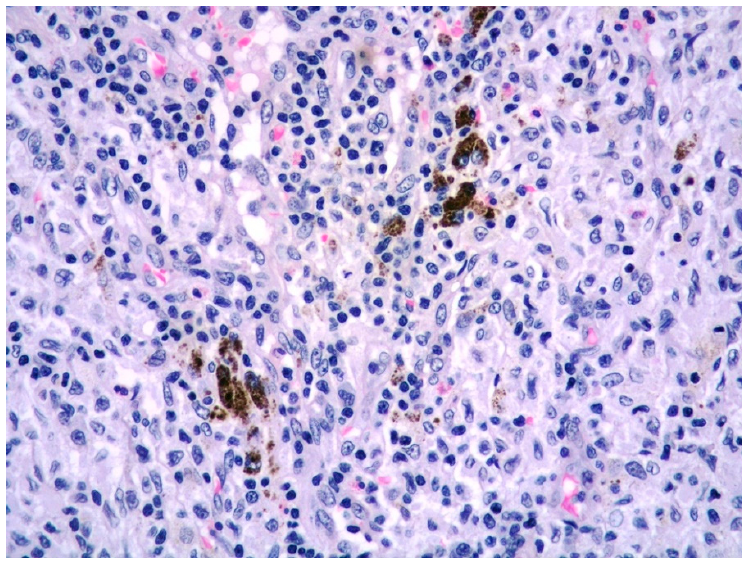
Figure 2. High power view of dermatopathic lymphadenitis with melanin-laden macrophages (HE, 400× magnification).